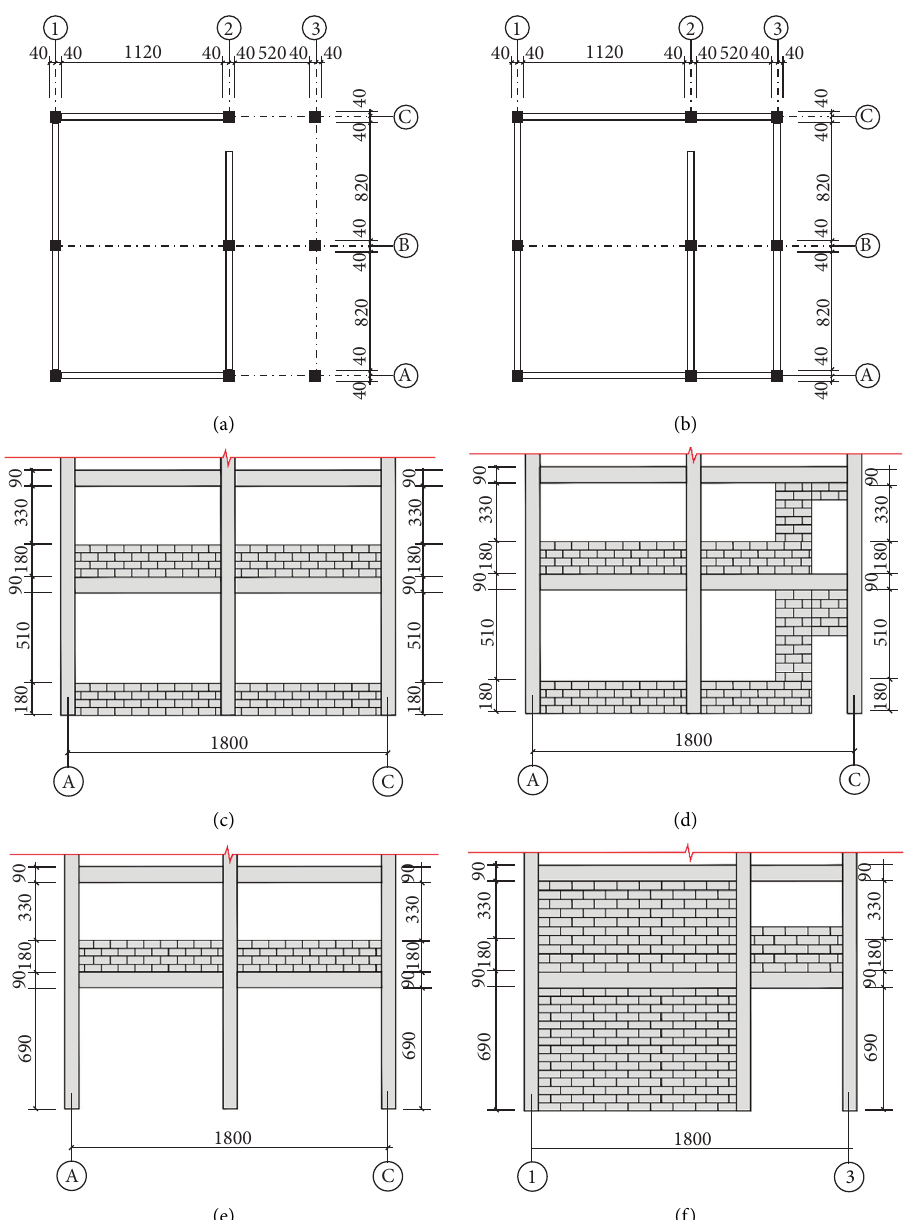
Figure 17: The architectural drawing of side corridor infilled wall RC frame (unit: mm). (a) First-floor plan. (b) Second-floor plan. (c) 1-axis elevation. (d) 2-axis elevation. (e) 3-axis elevation. (f) Ⓐ / Ⓒ axis